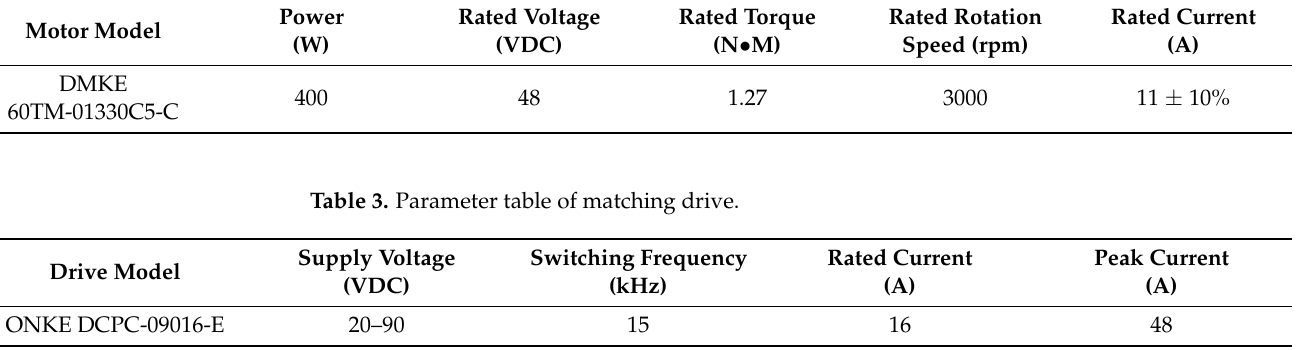
Table 2. DC servo motor parameter table. Table 3. Parameter table of matching drive.